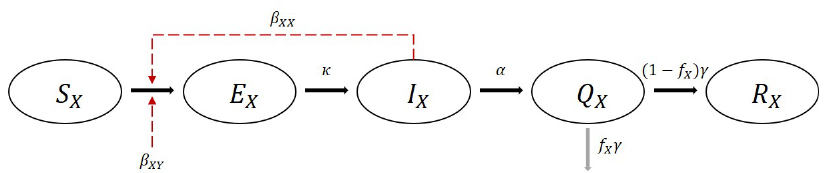
Figure 1. Flowchart of the mathematical model of the COVID-19 epidemic in Korea considering group